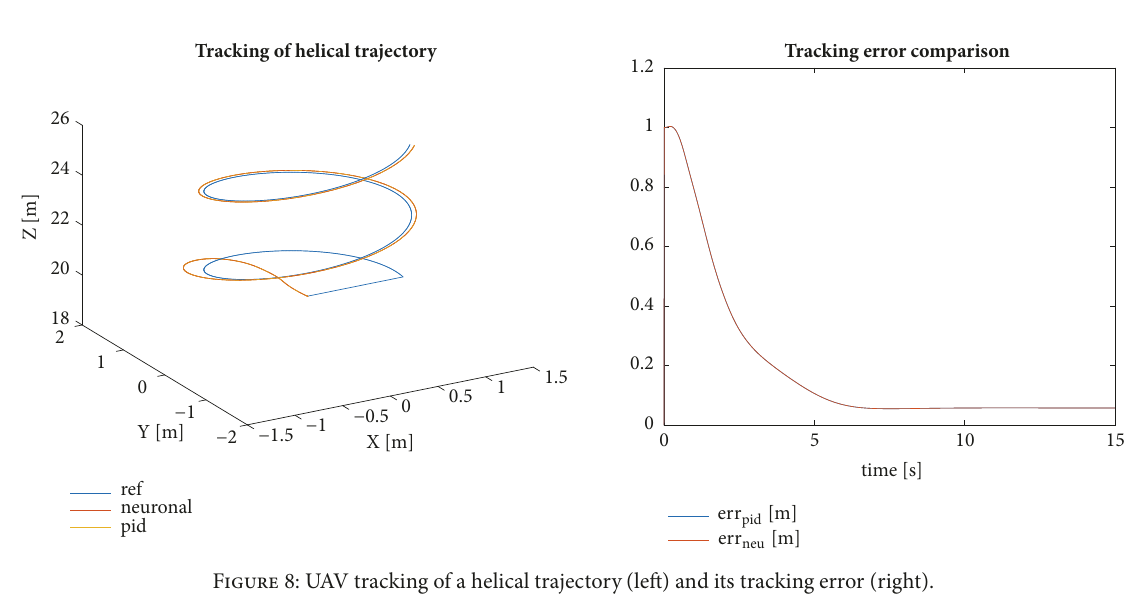
Figure 8: UAV tracking of a helical trajectory (left) and its tracking error